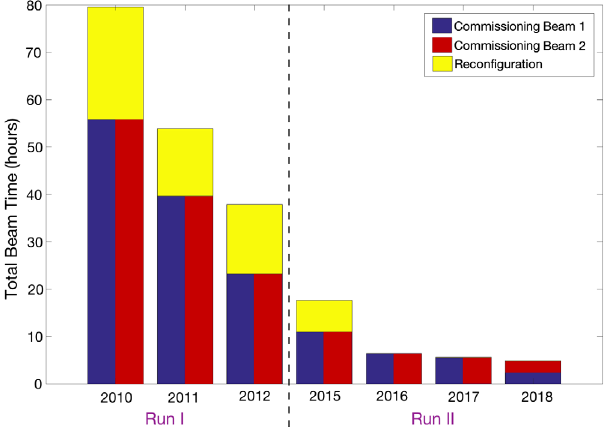
FIG. 5. The time taken to align all collimators for commission- ing and any reconfigurations, during runs I and II. During 2010 – 2017 the collimators in the two beams were aligned in parallel (vertical bars), whereas in 2018 they were aligned one after the other (horizontal